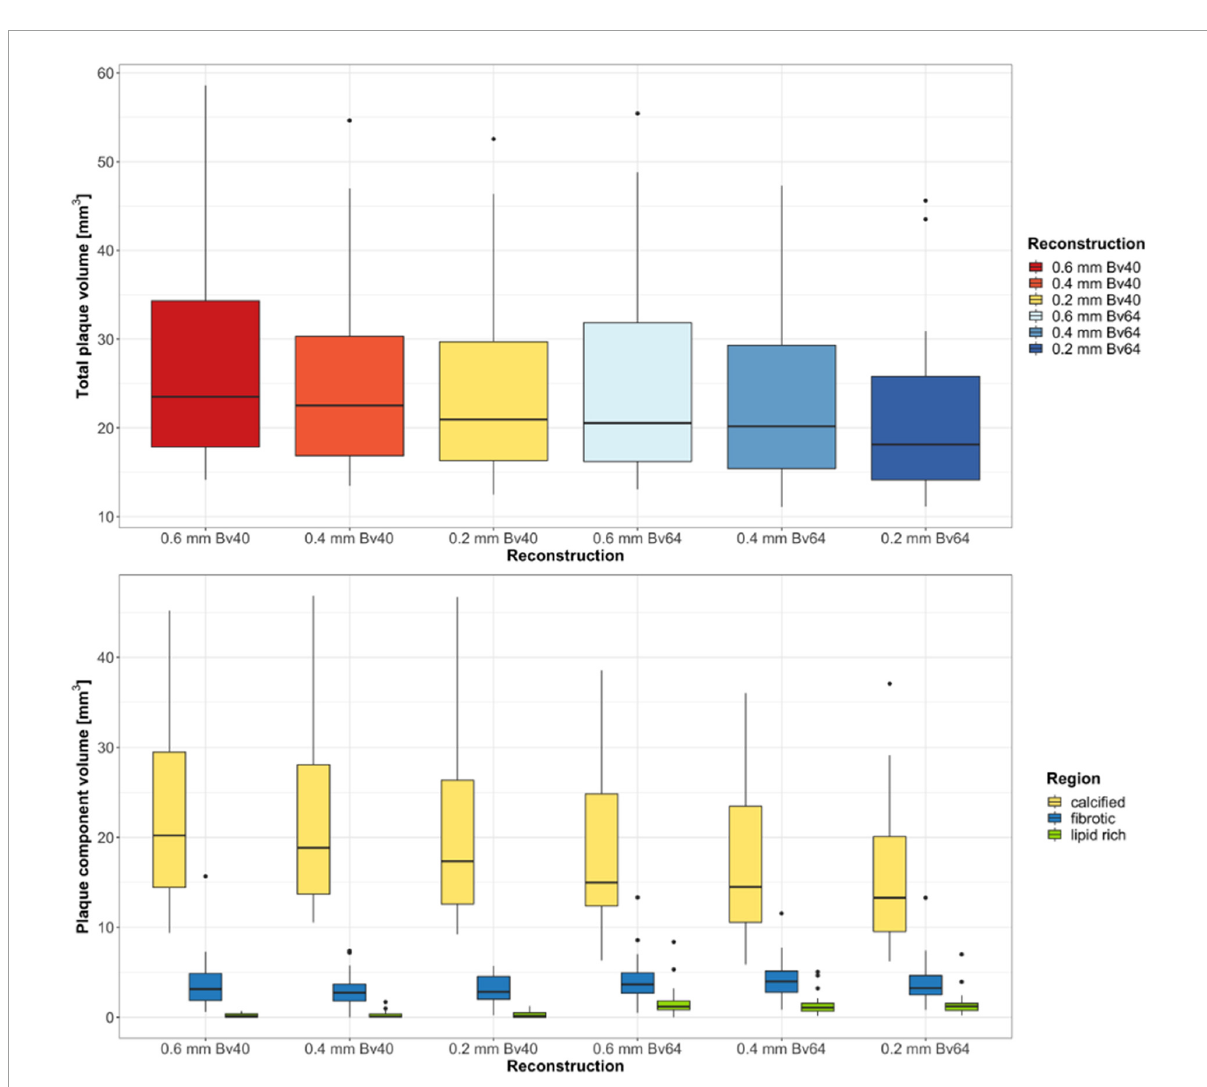
FIGURE2 Results of the quantitative plaque analysis. Boxplots at the top show the total plaque volume and boxplots at the bottom depict the volume of the different plaque components determined on reconstructions with three different slice thicknesses and two different kernel strengths. Horizontal lines in the boxes indicate the median, and the top and bottom lines of boxes indicate the first and third quartiles, respectively. Whiskers show lowest and highest values within 1.5 interquartile range of the lower and upper limits, and circles indicate